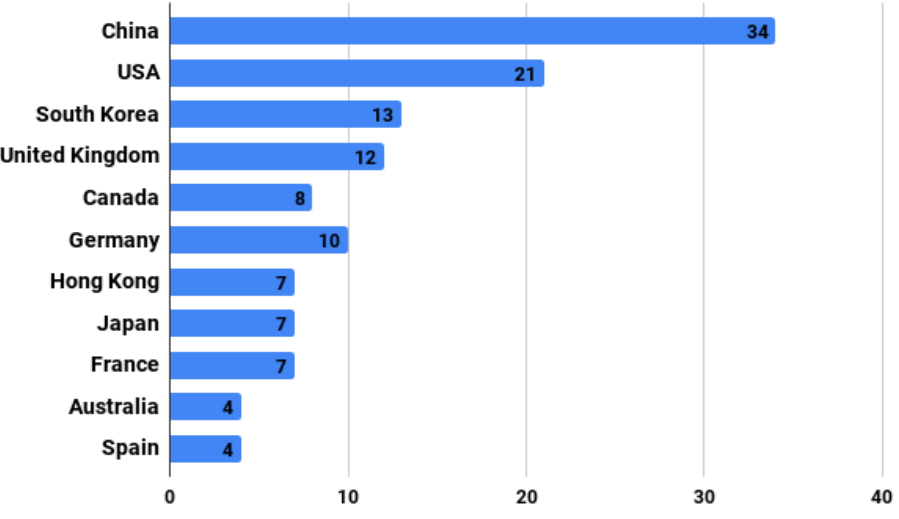
Figure 3. Distribution of studies over top 15 countries of first authors.